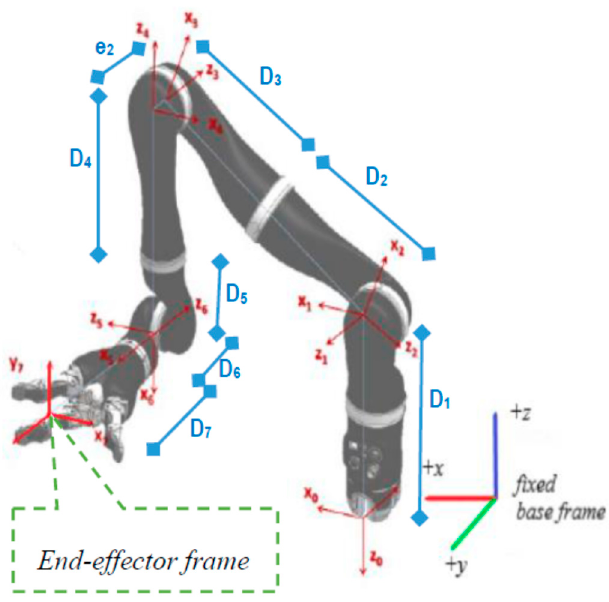
® JACO -2 robotic arm kinematic structure and frames. Figure 3. Kinova ® JACO-2 robotic arm kinematic structure and frames. Figure 3. Kinova Table 1. D-H Parameters of a Kinova ® JACO -2 7- DoF Assistive robotic